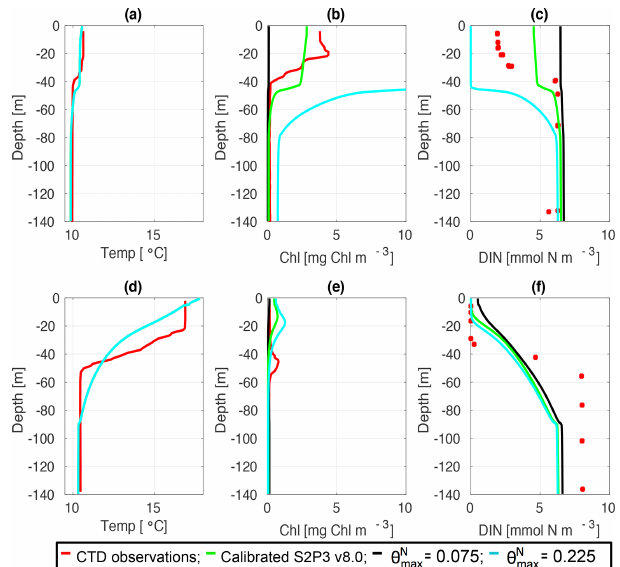
Figure C8. CTD observations from the SSB programme (red line) including data for springtime (20 April 2015) (a) tempera- ture, (b) chlorophyll a , and (c) DIN (red dots); for summertime (24 July 2015) for (d) temperature, (e) chlorophyll a , and (f) DIN (red dots) along the calibrated S2P3 v8.0 model (green line), exper-